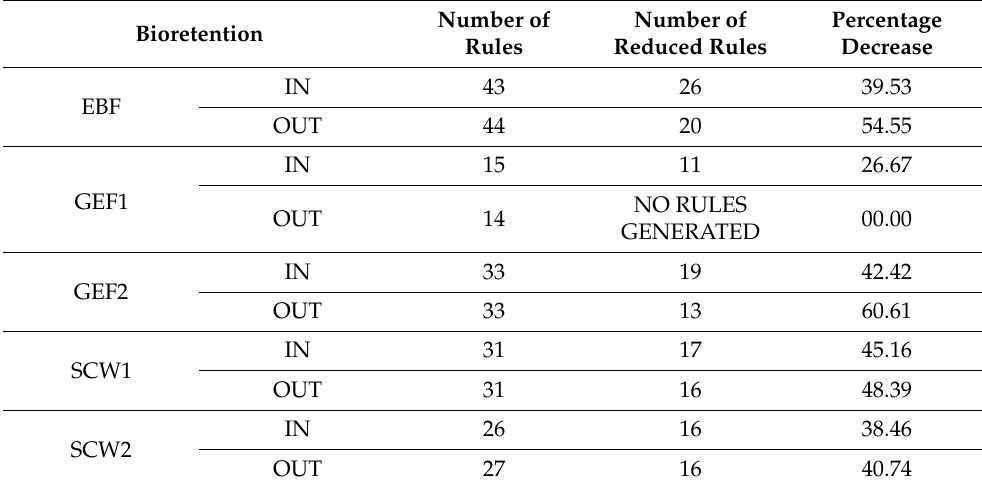
Table 7. Percentage decrease in rules